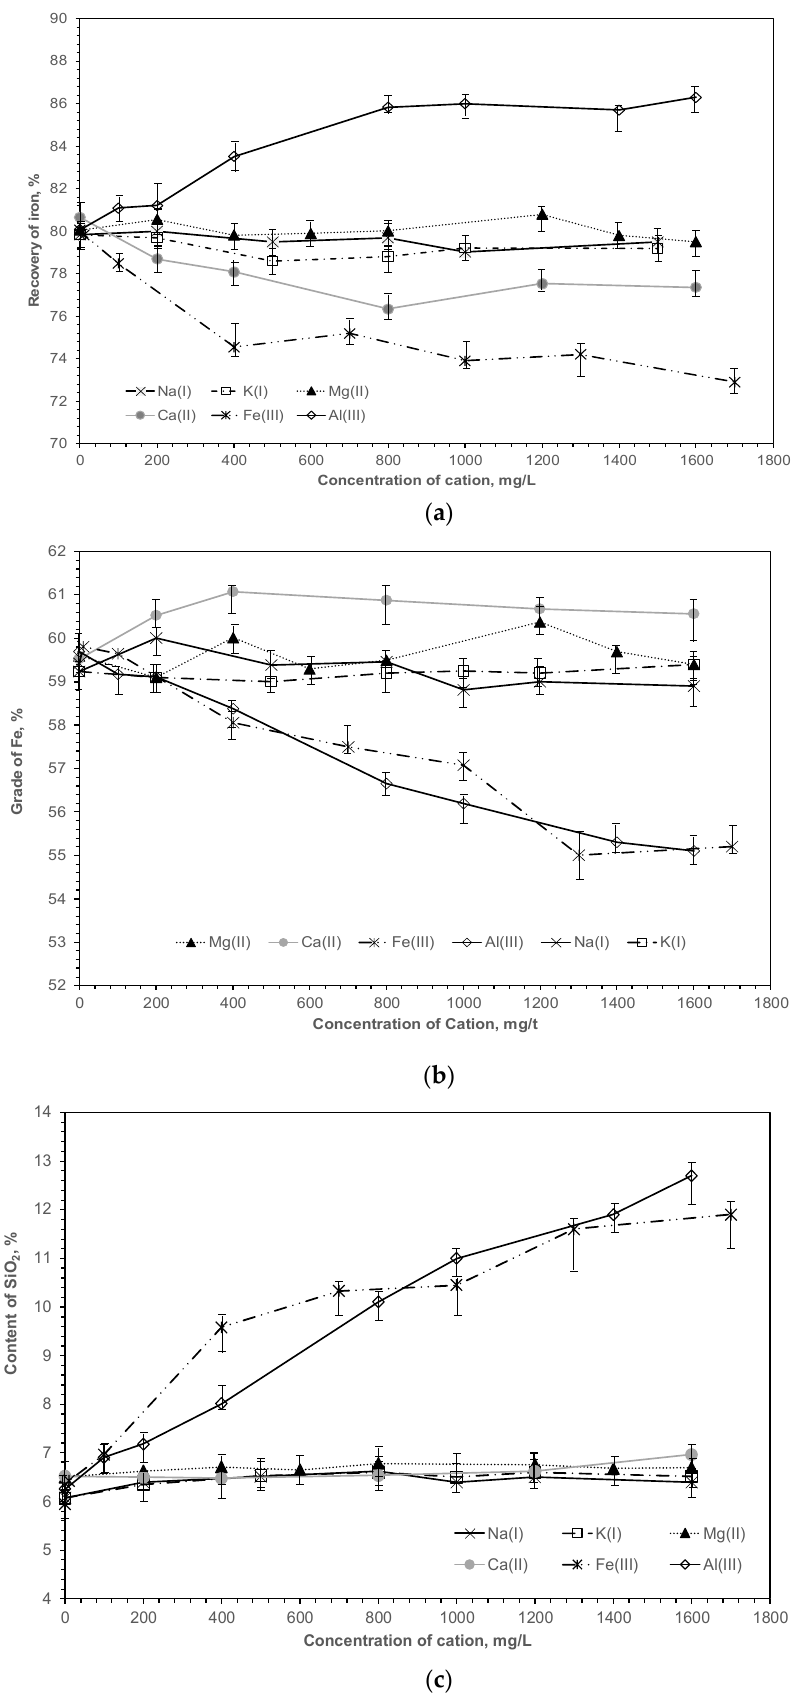
Figure 3. The effect on the recovery/grade of Fe and content of SiO 2 in concentrate as a function of dosage of cation in the tap water: ( a ) Recovery of Fe, ( b ) Grade of Fe, and ( c ) Content of SiO 2 .